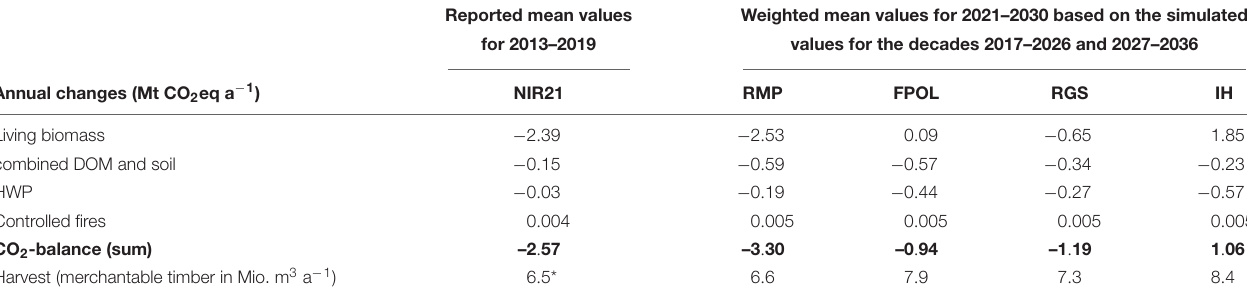
TABLE 2 | Mean CO 2 -balances of the Swiss Forest sector [i.e., managed forest land including Harvested Wood Products (HWP)] as reported in the Swiss National Inventory Report 2021 for the period 2013–2019 (NIR21) and as calculated for 2021–2030 from the projections of the conceptual scenarios RMP, FPOL, RGS, and IH. Reported mean values Weighted mean values for 2021–2030 based on the